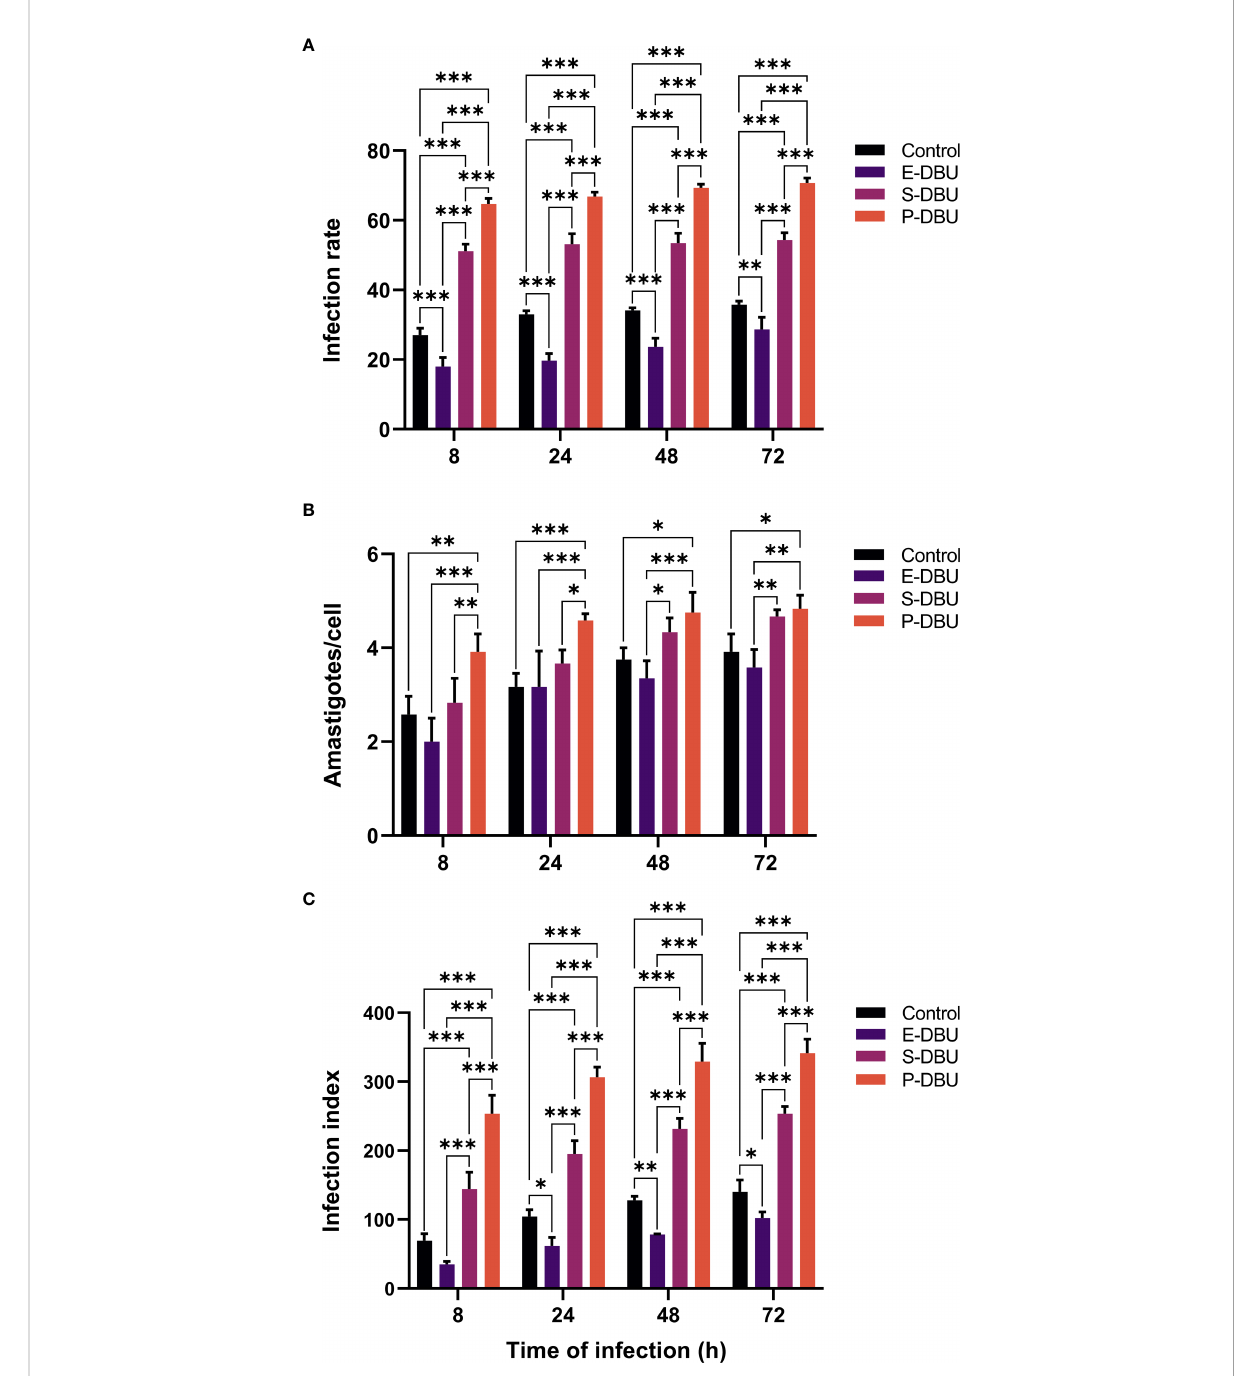
FIGURE 4 Infection rate, the average number of intracellular amastigotes per cell, and infection index of L. orientalis promastigotes for THP-1 macrophages. Exponential phase promastigotes (E-DBU), stationary phase promastigotes (S-DBU), and non-PNA agglutinated promastigotes (P- DBU) cultured in SIM, pH 5.0 with DBU and 10% (v/v) FBS and promastigotes cultured in SIM, pH 7.0 (control) were used to infect THP-1 macrophages. (A) Infection rate, (B) the average number of intracellular amastigotes per cell, and (C) infection index were determined at 8, 24, 48, and 72 h post-infection. Statistically signi fi cant differences between groups are indicated as follows: * P < 0.1; ** P < 0.01; *** P <